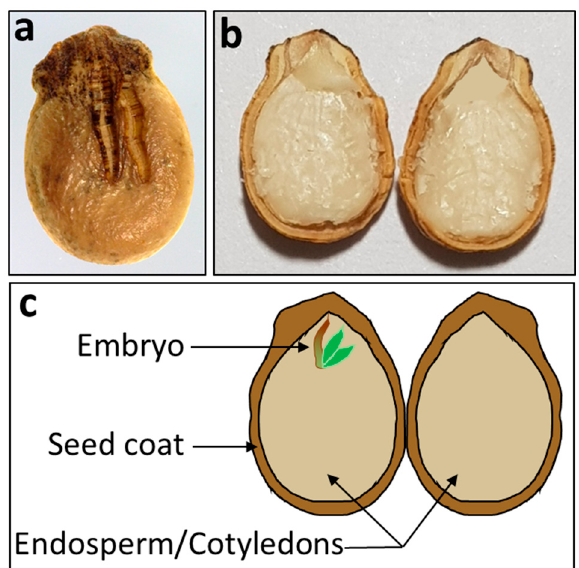
Figure 1. Basic components of a dicot seed (watermelon). ( a ) external view and ( b ) internal view of seed; ( c ) illustration of major parts of seed.